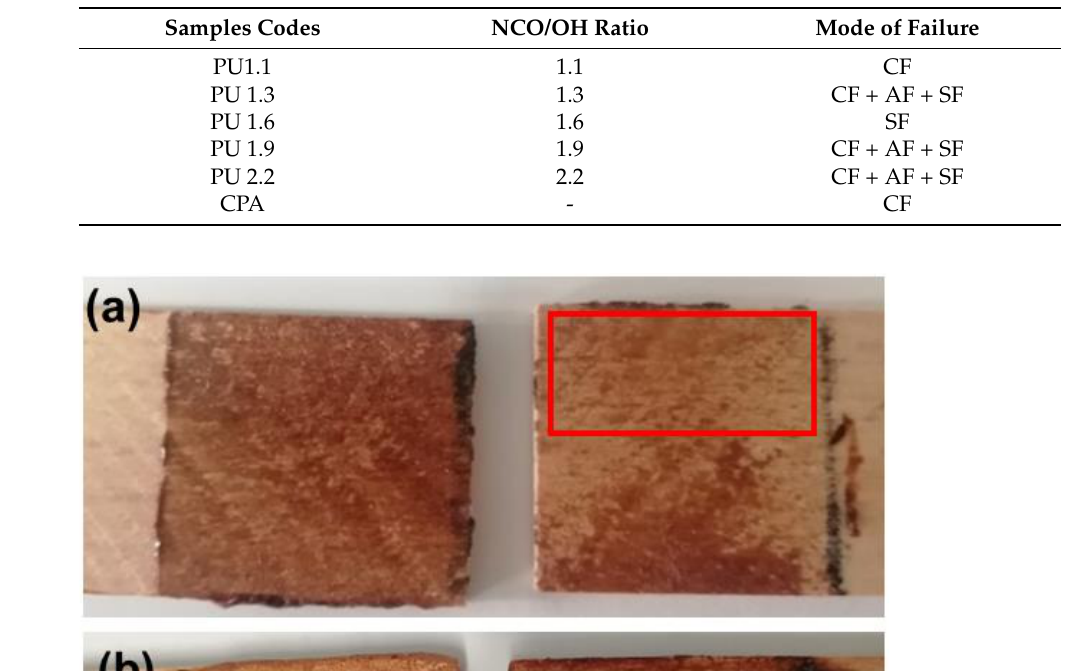
Table 3. The effect of NCO/OH ratio on the mode of failure.